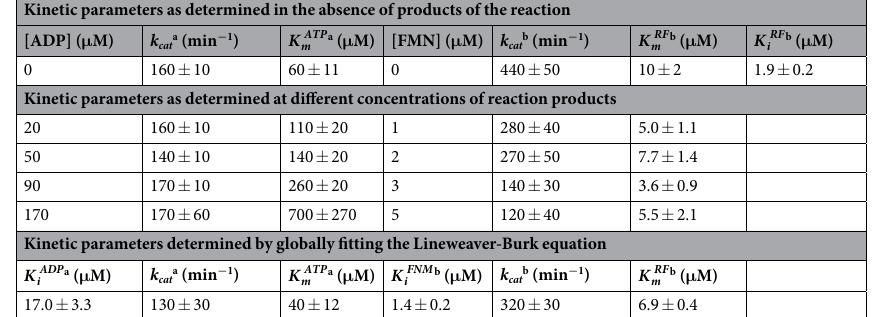
Table 1. Steady-state kinetic parameters describing the RFK activity of the RFK module and the inhibition by its different substrates and products. Data obtained at 25 °C in 20 mM PIPES and 0.8 mM MgCl 2 , pH 7.0. Inhibition by the RF substrate prevented the determination of true parameters, and the data that is presented correspond to apparent constants. a Parameters estimated using an RF concentration at which activity was ∼ 80% of maximal(~5 µ M). b Determined at saturating ATP